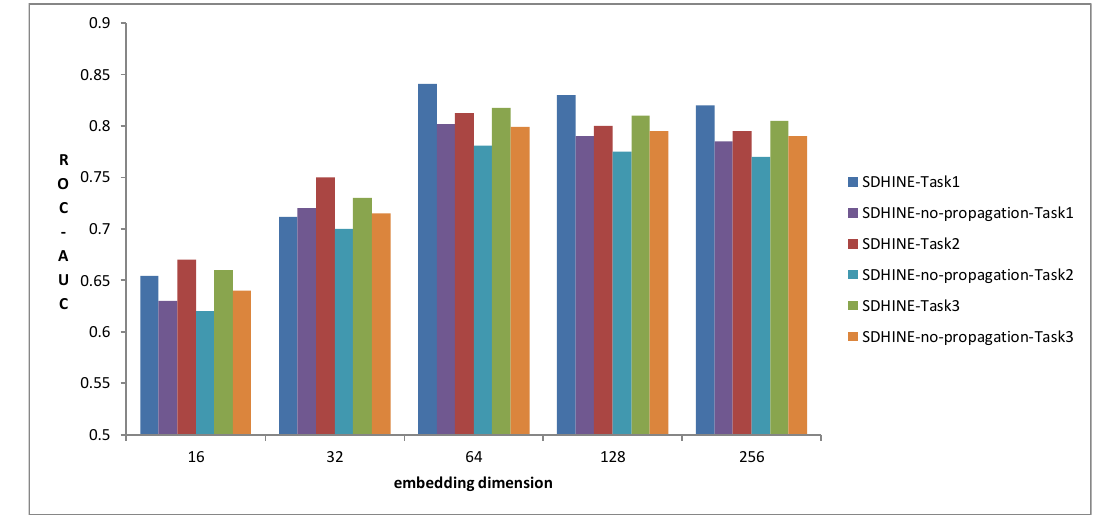
Figure 7. Performance comparison of different embedding